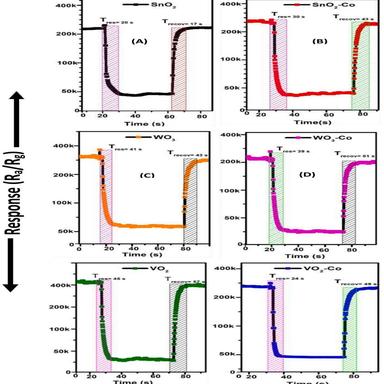
Dynamic response and recovery times of (a) WO3, (b) WO3-Co, (c)SnO2, (d) SnO2-Co, (e) VO2, and (f) VO2-Co-based sensors versus operating temperatures to 5 ppm acetone concentration. (For interpretation of the references to colour in this figure legend, the reader is referred to the web version of this article.)